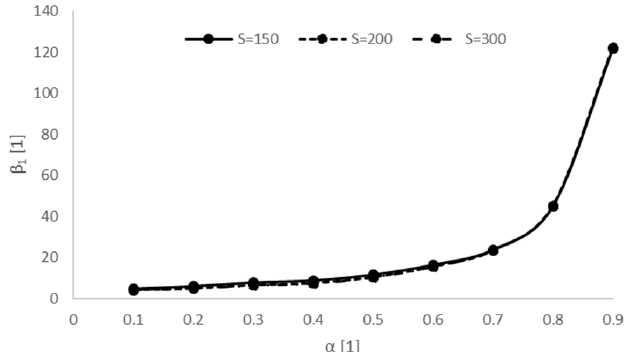
Figure 3: The values of normalized stress intensity factor B 1 for three cases of homogeneous concrete specimens of lengths S =150, 200, 300